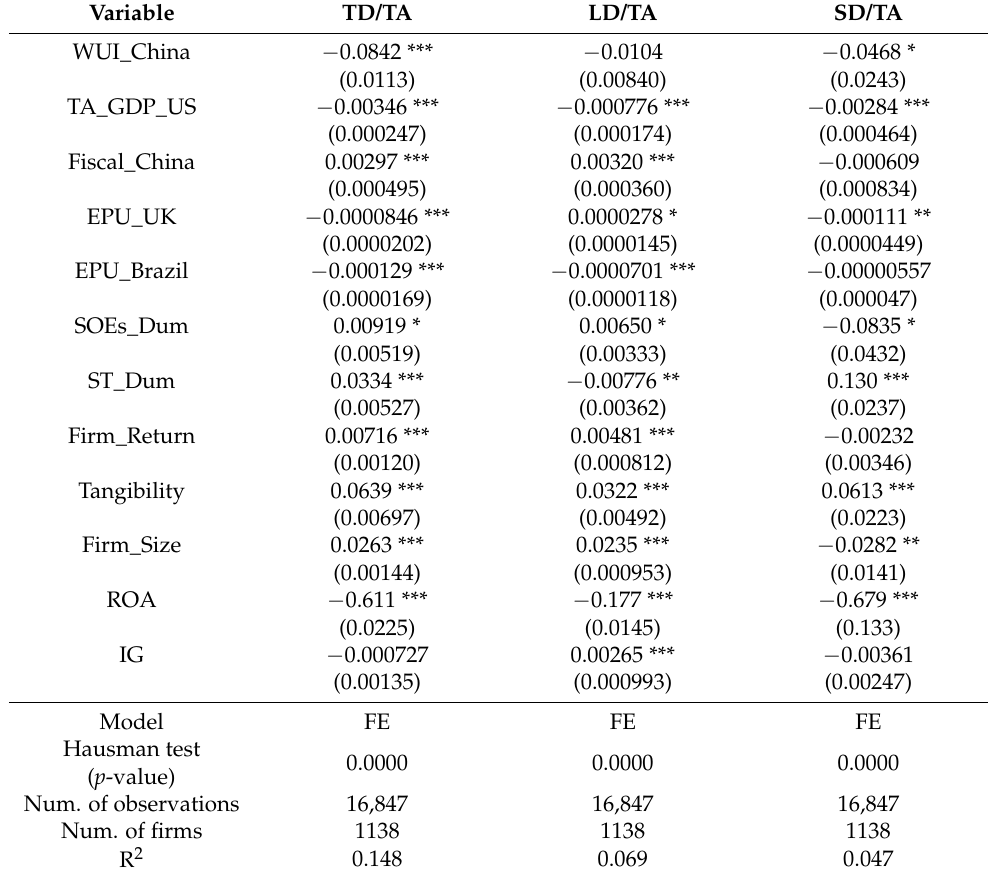
Table 2. The impacts of economic uncertainty on corporate capital